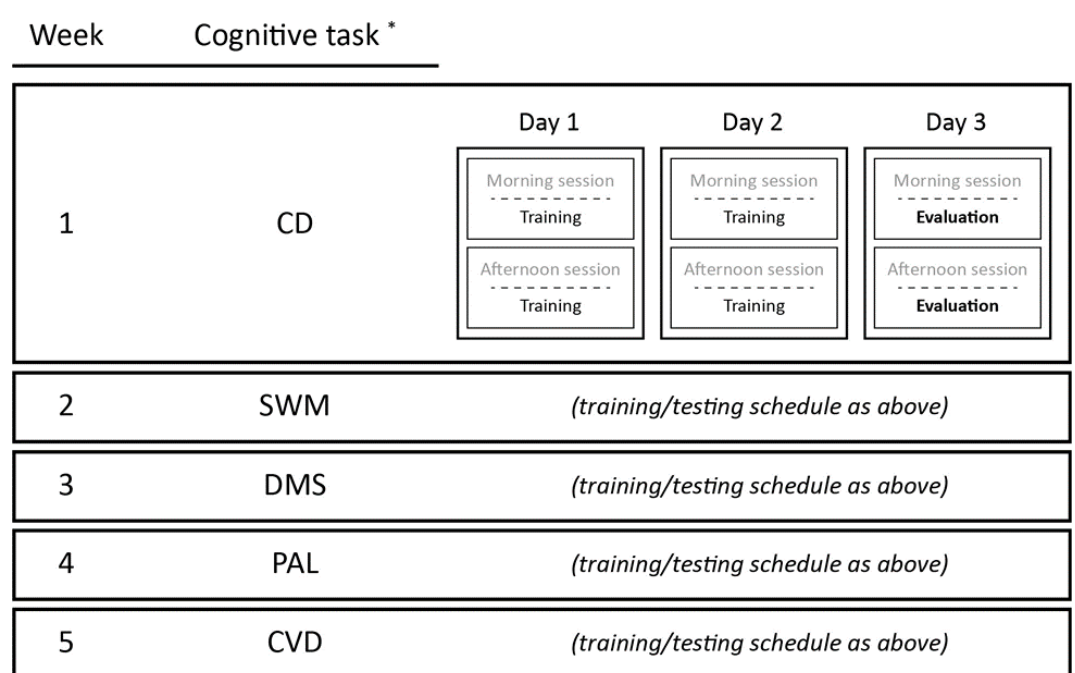
Schematic of the General Training and Testing Schedule